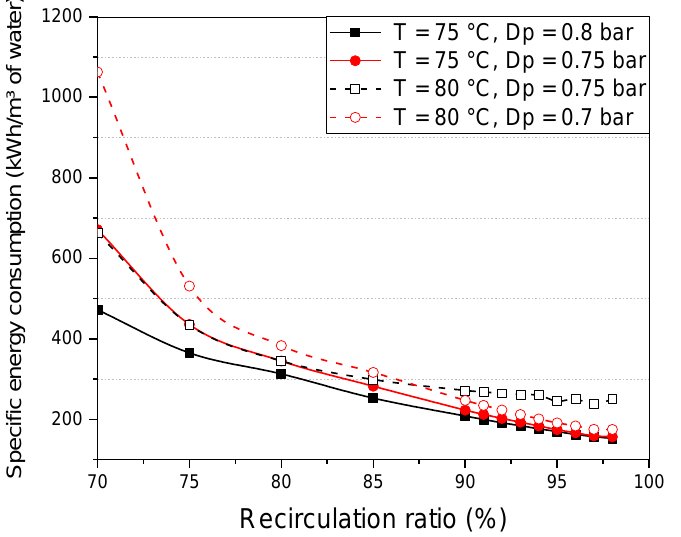
Figure 14. Specific energy consumption as the recirculation ratio increases for ∆ p = 0.7, 0.75 and 0.8 bar.